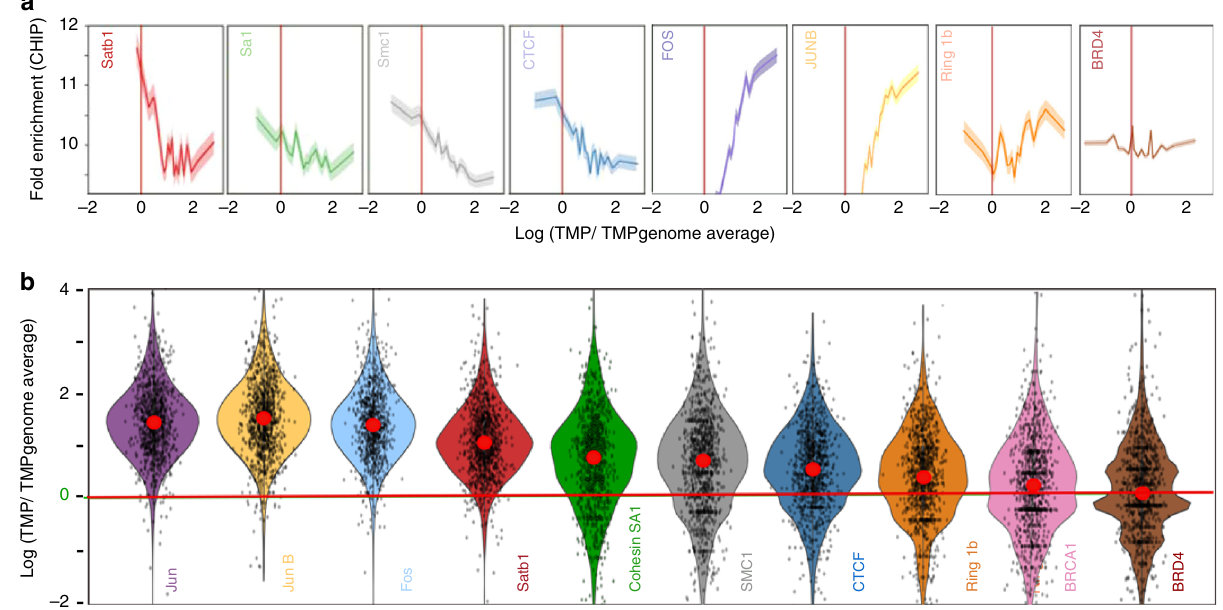
Fig. 5 DNA torsion sensitivity of different classes of chromatin binding proteins. a Plots of CHIP-seq fold enrichment versus TMP signal enrichment (expressed as the logarithm of the ratio of mean TMP-seq reads of a 400 bp genomic window centered on the binding sites and the background TMP-seq signals) of 8 different chromatin binding proteins (for details see methods). All error envelopes represent standard error of mean. b Violin plots showing the distribution of background corrected TMP-seq signals for the top 20% strongly represented CHIP-seq peaks for 10 different chromatin binding proteins. 1000 randomly selected data points are displayed on each violin. Red dots represent the median of the distribution. Fos, Jun and JunB, are transcription factors that bind known consensus sequence motifs in nucleosome-depleted regions. BRCA1 is a DNA damage repair protein. Ring1b is a component of the Polycomb group (PcG) proteins. BRD4 binds to acetylated histones in a DNA sequence-independent manner. Satb1, CTCF, Cohesin SA1, and SMC1 are chromatin architectural proteins. Satb1 CHIP-seq data, and TMP-seq data shown here can be accessed through GEO (Accession number: GSE123292). For all the other proteins, publicly available CHIP-seq data were used. See Methods for the accession numbers. Source data are provided as